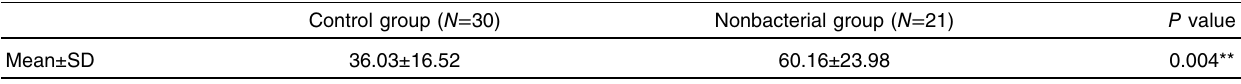
Table 6 Comparison between mean values of serum procalcitonin in the nonbacterial and control groups